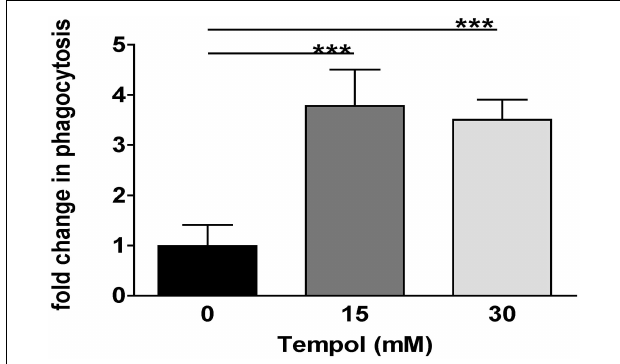
FIGUREA3 |Tempol enhances PMN phagocytosis of Staphylococcus aureus bioparticles. The effect ofTempol on PMN phagocytosis was analyzed using Staphylococcus aureus bioparticles. Cytochalasin D treatment was used as a means to block PMN phagocytosis as a negative control. Black bar: PMN phagocytosis without treatment was set as 1. Gray bars: Fold change of PMN phagocytosis upon treatment with 15mM Tempol (dark gray) and 30mMTempol (light gray) as compared to untreated cells. Significance was analyzed byTukey one-way ANOVA (*** P ≤ 0.001). Data are presented as means from two independent experiments with three technical replicates each ±